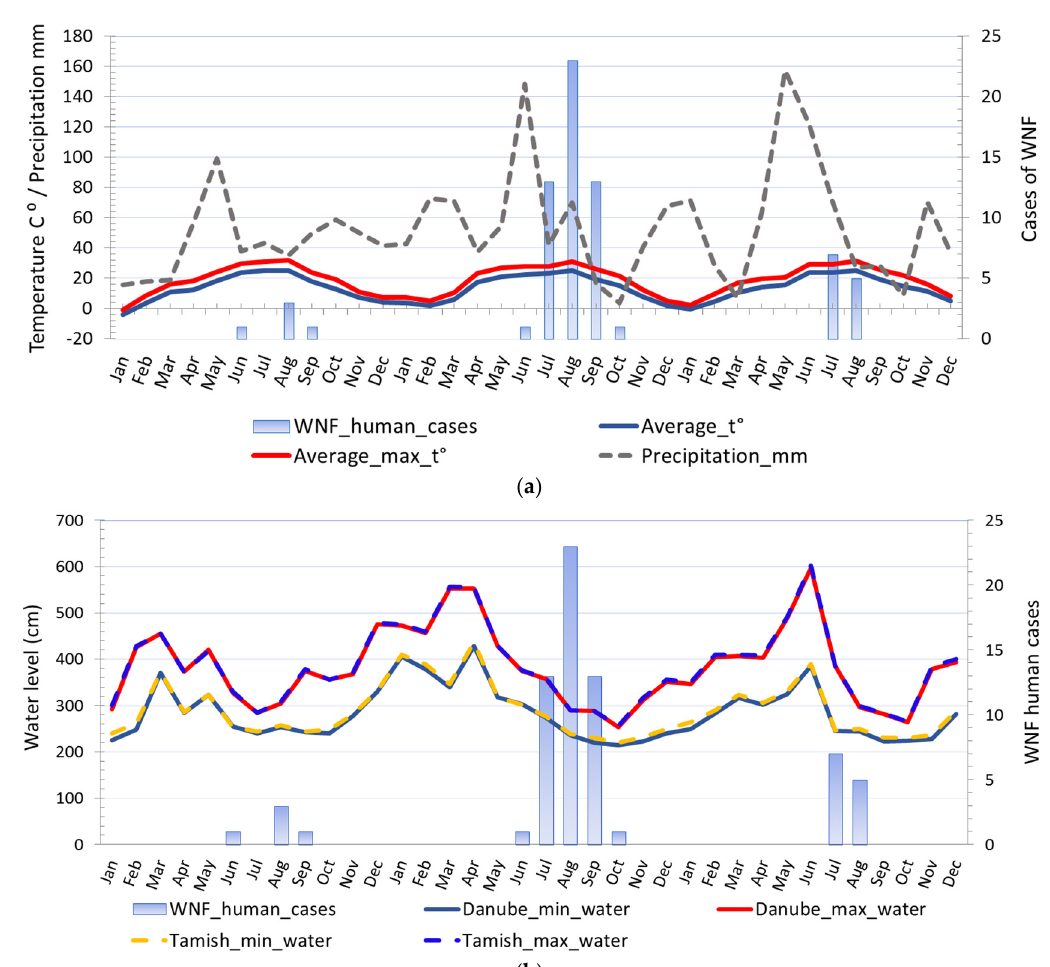
Figure 6. Comparison of different climatic risk factors and distribution of registered WNV human cases in 2017, 2018, and 2019: ( a ) Seasonal fluctuations in temperature, precipitation, and registered cases of WNV infection in humans; ( b ) seasonal fluctuations in water levels and registered cases of WNV infection in humans.